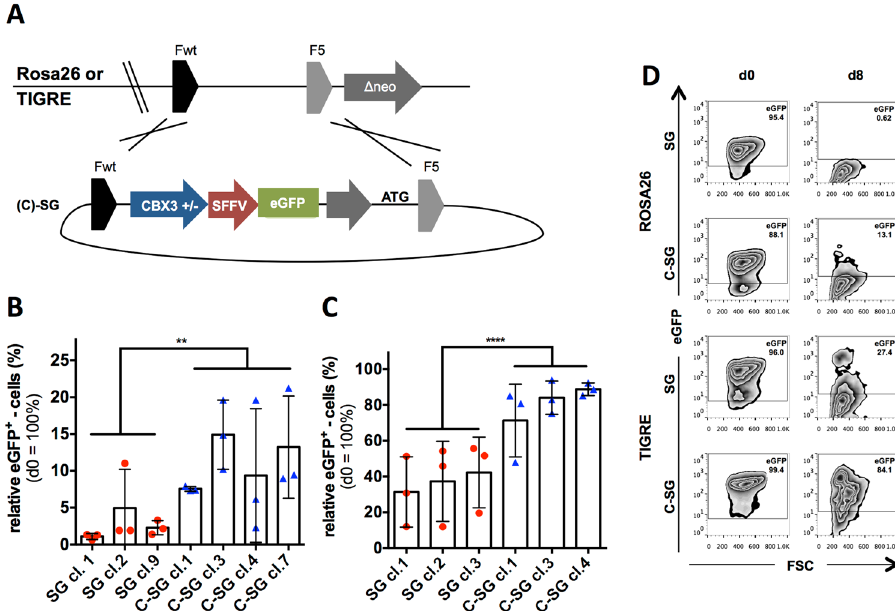
Figure 6. Anti-silencing function of the CBX3 at two defined chromosomal loci. ( A ) Murine ESCs were targeted at either the ROSA26 or the TIGRE chromosomal locus by using FLP-mediated cassette exchange to introduce either an SFFV.eGFP (SG) or CBX3.SFFV.eGFP (CSG) cassette. Subclones of ( B ) ROSA26- (SG: 3 clones; CSG: 4 clones) and ( C ) TIGRE- (SG: 3 clones; CSG: 3 clones) targeted cells were subjected to EB- based undirected differentiation and the relative percentage of eGFP-expressing cells was determined by flow cytometry on day 8 in SSEA-1 negative cells (d0 = 100%). ( D ) Representative flow cytometric analysis of targeted cells on day 0 and day 8. Bar charts represent mean ± SD; n = 3 per clone. Student’s t-test